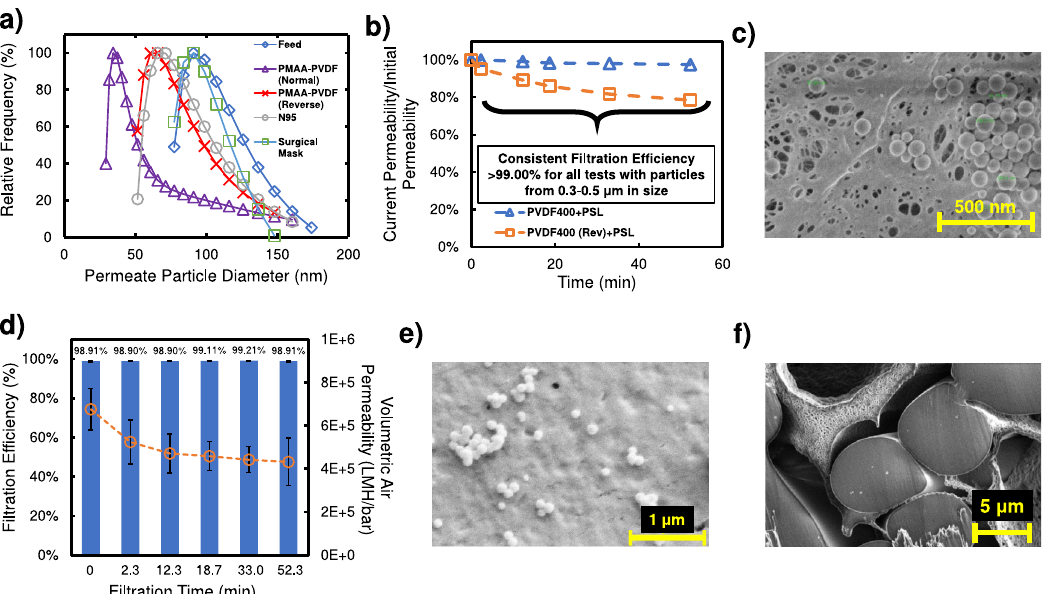
Fig. 4 PSL aerosol fi ltration through membrane material. a PSL particle size distribution (22.7 °C) at an atomizer inlet pressure of 0.7 bar and a relative humidity (RH) of 68% after 20 min of fi ltration. Particle size quanti fi ed using DLS (volume-weighted measurements). N95 and surgical masks consists of all layers (purple triangle and line for PMAA-PVDF-Normal, red cross mark and line for PMAA-PVDF-Reverse, gray circle and line for N95, blue diamond for feed, and green square for surgical mask). b PSL particle air- fi ltration and permeability drop of unfunctionalized PVDF400 in normal (blue diamond and dashed line) and reverse orientation (orange square and dashed line). This result is from a single sample with <0.5% deviation in triplicate measurements. Feed air concentration was ~37,000 0.3 – 0.5 μ m aerosol particles/L with RH of 21%. Particle count measured using Met One Instruments ’ GT-526S particle counter. Flow rate measurements normalized at STP. c SEM image of a PVDF400 membrane surface after aerosol fi ltration (consisting of clusters of 100- nm PSL particles) for 10 min (RH = 68%). d PSL particle air- fi ltration and permeability drop of Subtilisin-PMAA-PVDF (blue bar for fi ltration ef fi ciency, orange circle, and dashed line for permeability). Feed air concentration ~42,000 0.3 – 0.5 μ m aerosol particles/L with relative humidity of 23%. Particle count measured using Met One Instruments ’ GT-526S particle counter. Flow rate measurements normalized at STP. e SEM image of Subtilisin-PMAA- PVDF membrane surface after 100-nm PSL aerosol fi ltration for 52 min. f SEM cross-section image of polyester layer of Subtilisin-PMAA-PVDF membrane after 52 min of aerosol fi ltration (consisting of clusters of 100-nm PSL particles). Cross-section obtained using ion milling. Error bars represent the standard deviation of 3 different measurements taken on the